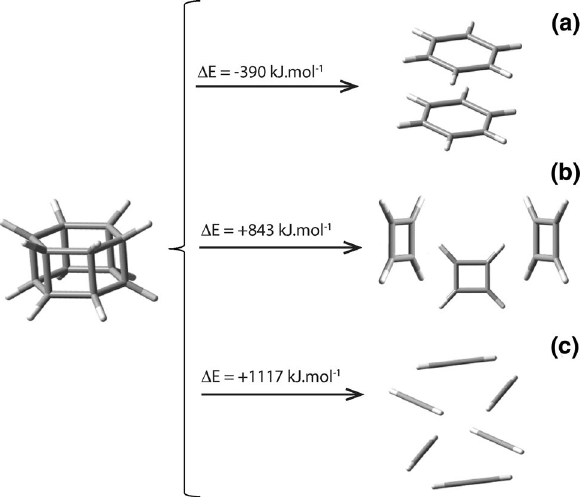
Figure 7. Pictorial representation of the dissociation reaction of nugget 12 into ( a ) two benzene molecules, C 12 H 12 → 2C 6 H 6 , ( b ) three cyclobutadiene compounds C 12 H 12 → 3C 4 H 4 , and ( c ) six ethyne molecules C 12 H 12 → 6C 2 H 2 . The values of ΔE shown are from ωB97XD/6-31G* calculations and are given in kJ mol −1 units because they refer to chemical reactions involving one mole of reactant